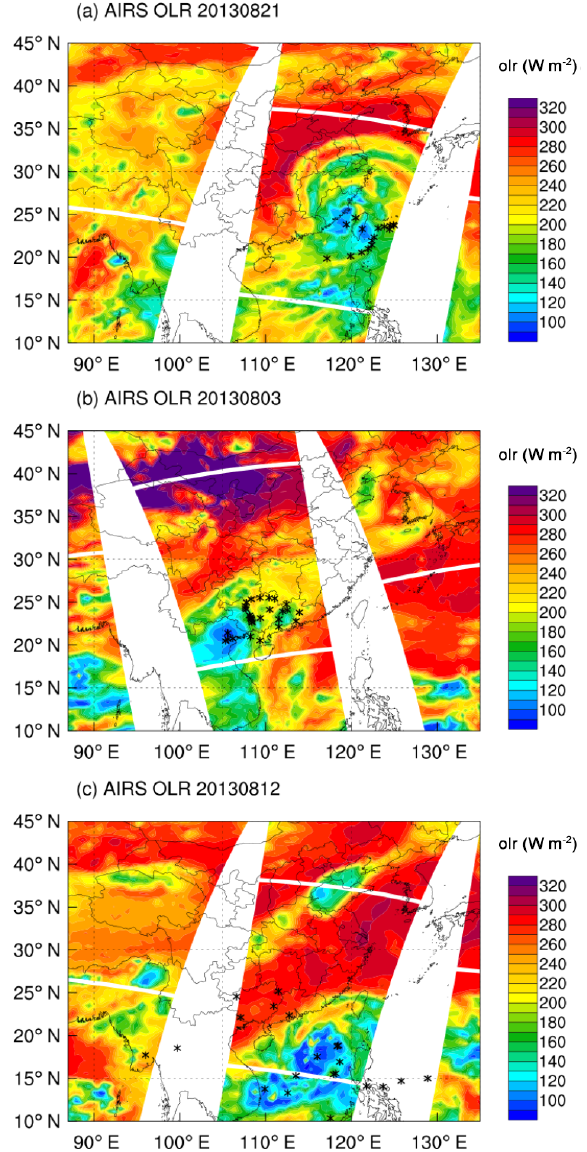
Figure 8. Outgoing long-wave radiation from AIRS satellite on 21, 3, and 12 August. The asterisks mark the locations of target air parcels at the time of the AIRS